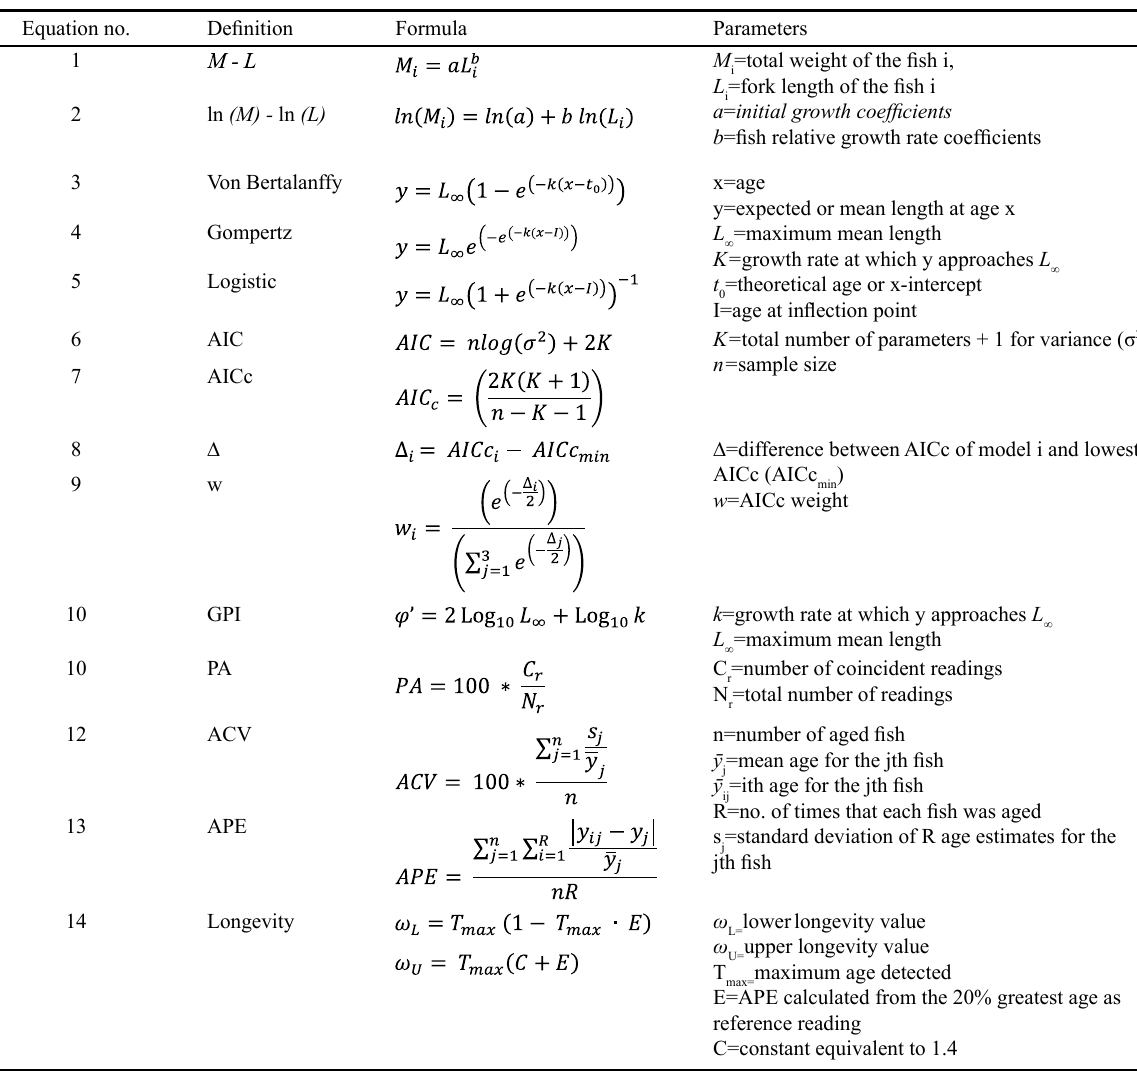
Table 1. – List of equations and parameters used in this study. Fork length (LF), body mass (M), natural logarithmic (ln), Akaike information criterion (AIC), small-sample bias-corrected form of AIC (AICc), Delta AIC (∆), AICc weight (w), growth performance index (GPI), percentage of agreement (PA), mean coefficient of variation (ACV) and average percent error (APE). Equation